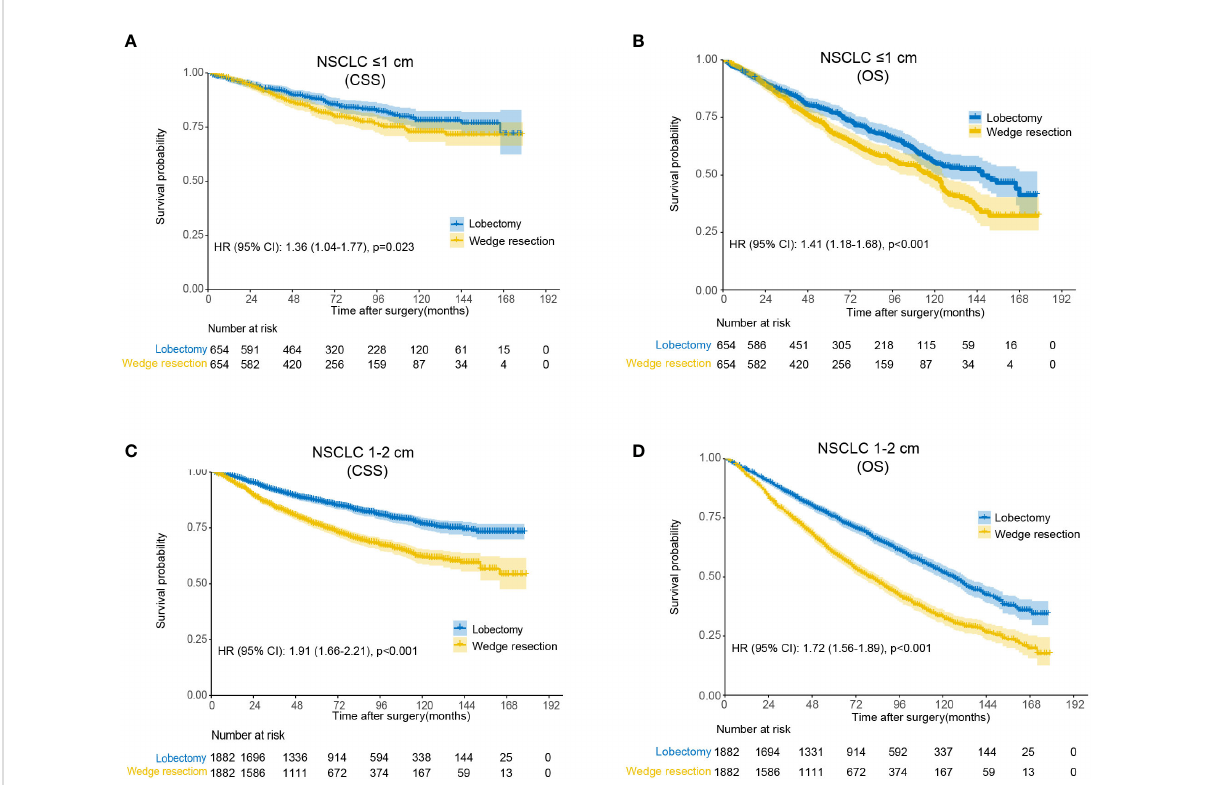
FIGURE 2 Kaplan-Meier analysis of survival between wedge resection and lobectomy after matching. (A) Cause-speci fi c survival for non-small cell lung cancer (NSCLC) ≤ 1 cm; (B) overall survival for NSCLC ≤ 1 cm; (C) cause-speci fi c survival for NSCLC 1-2 cm; (D) overall survival for NSCLC 1-2